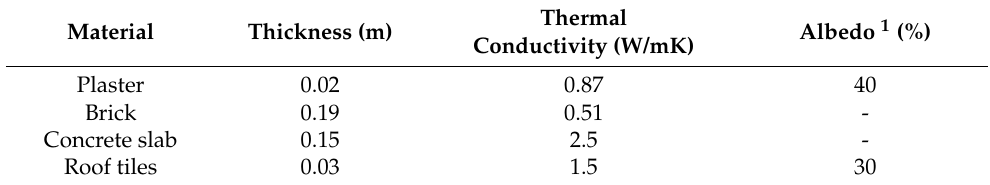
Table 3. Thermal and optical properties of the building envelope materials.